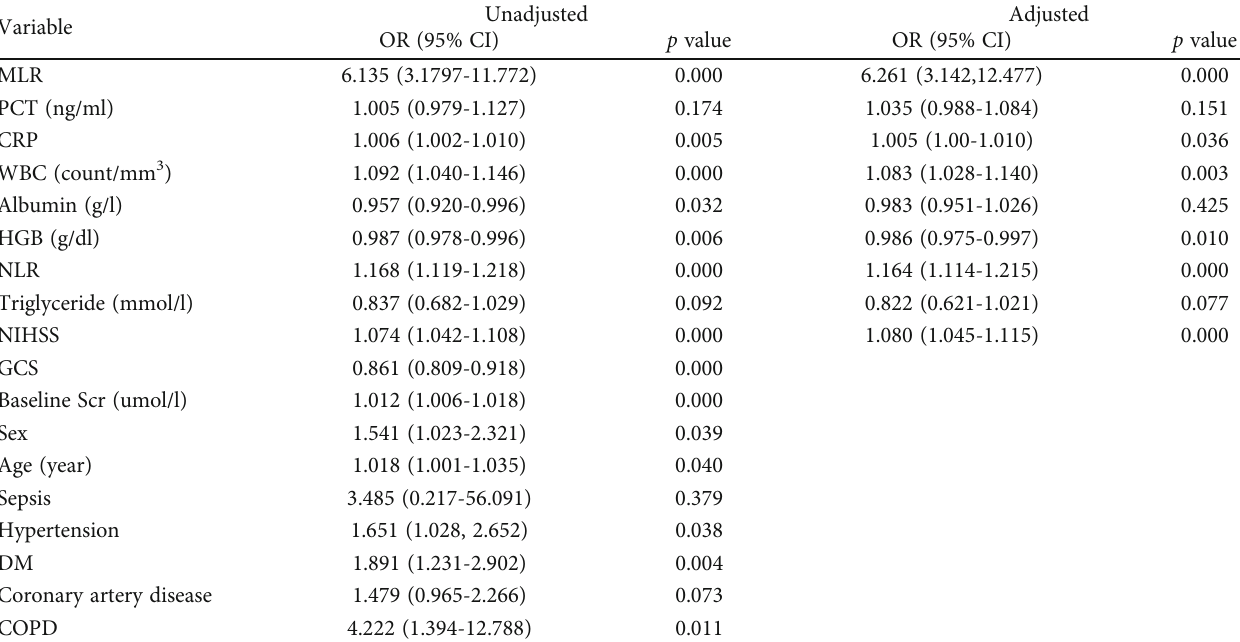
Table 3: values of the multivariable logistic regression analysis ’ MLR and NLR for AKI.